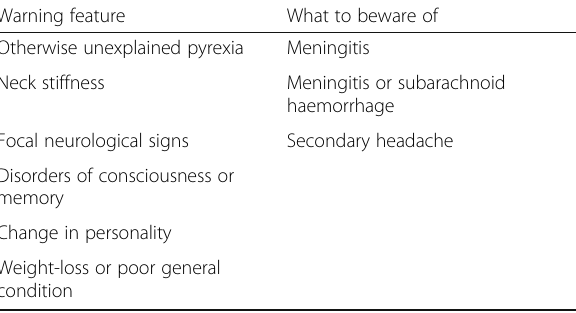
Table 6 Warning features on examination, when associated with headache Warning